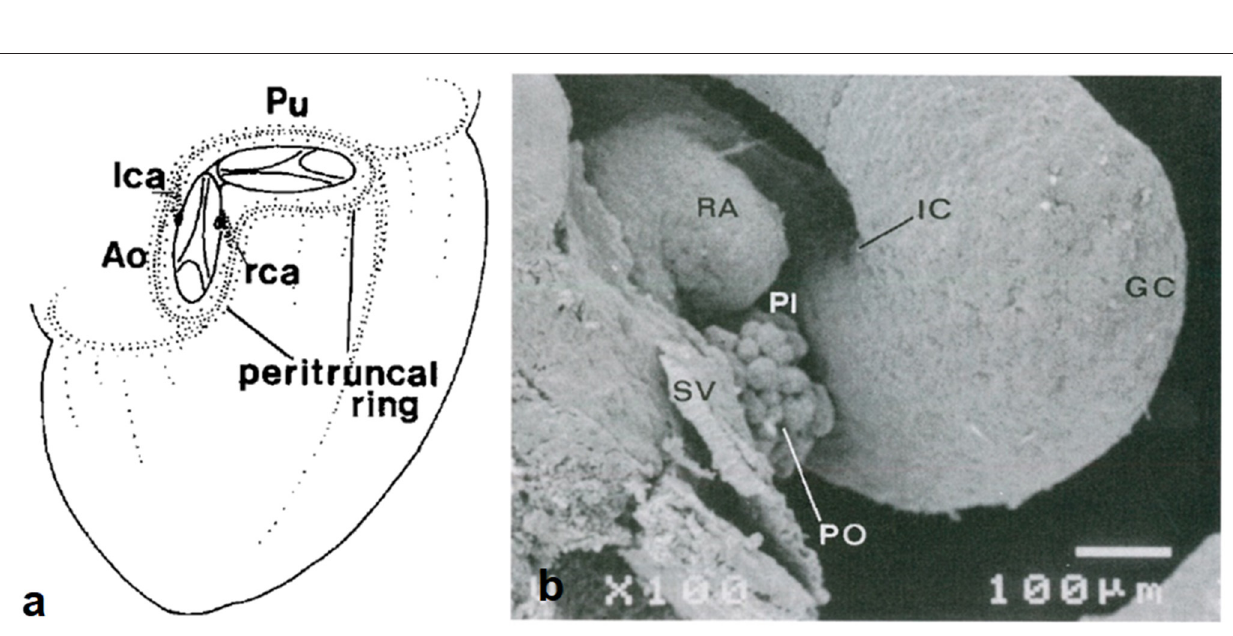
Frontiers in Cardiovascular Medicine |